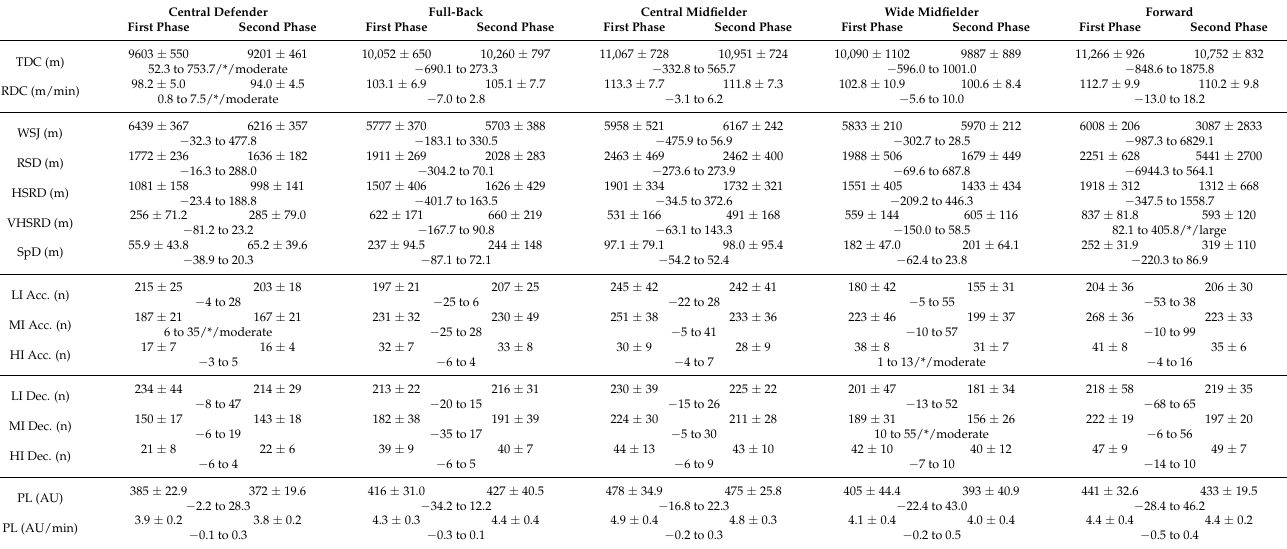
Table 4. External match load—comparison between the championship phases (first phase/second phase), mean ± SD, CI 95%, and